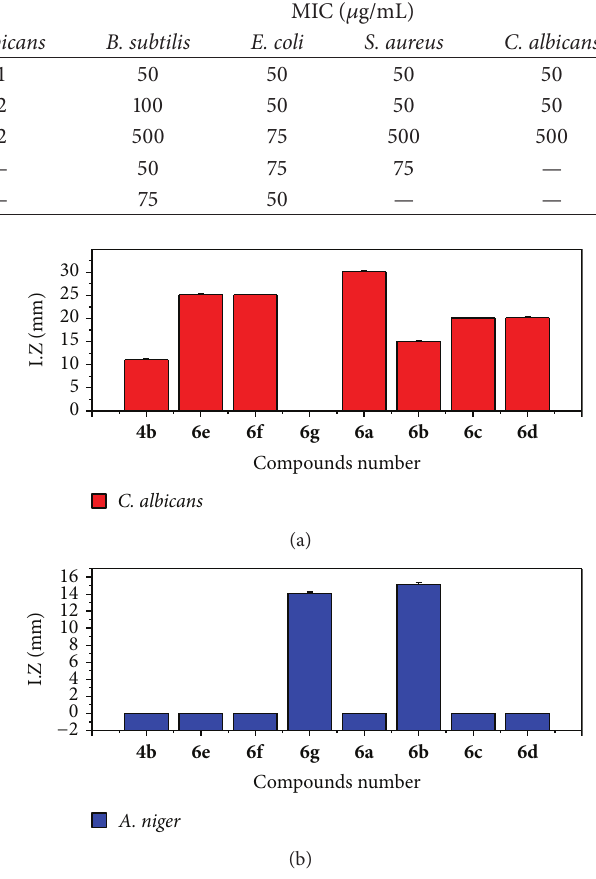
Table 2: MIC of different compounds against most of tested pathogens. Comp. number